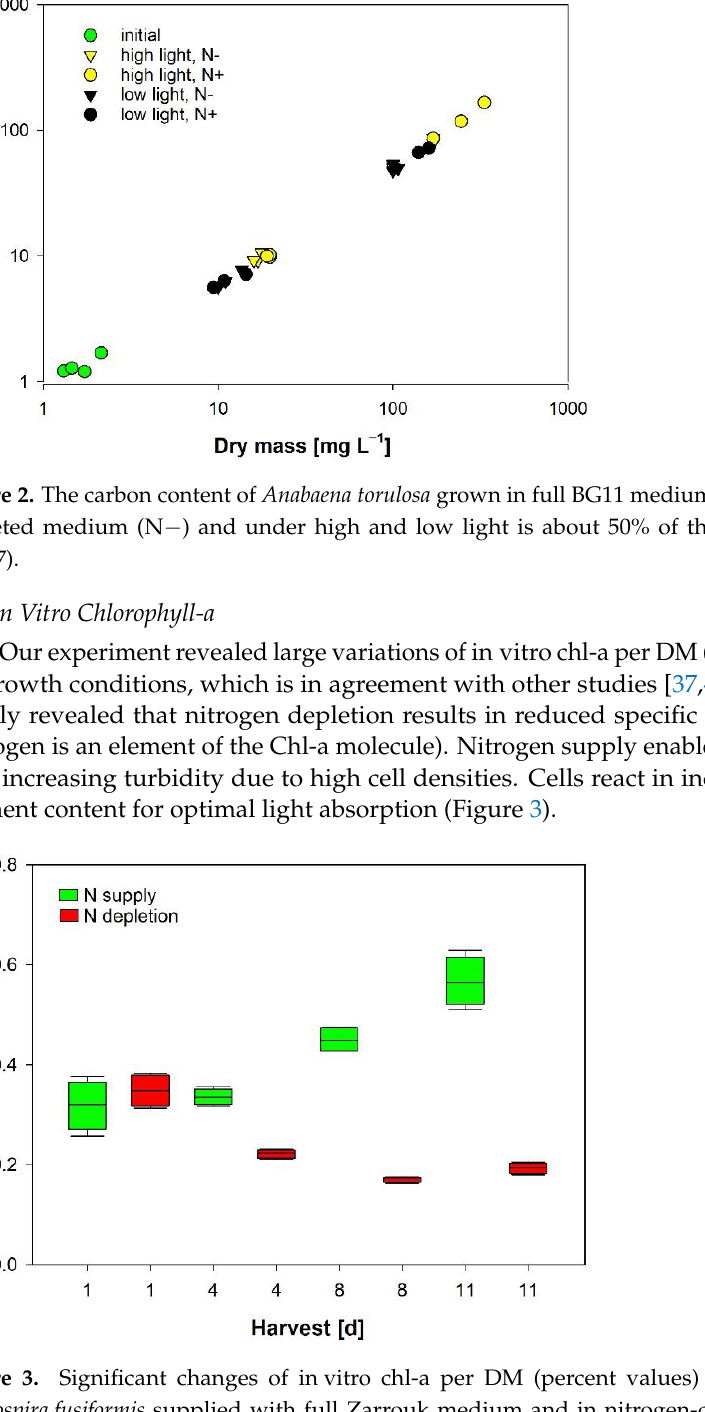
Figure 3. Significant changes of in vitro chl-a per DM (percent values) during cultivation of Limno- spira fusiformis supplied with full Zarrouk medium and in nitrogen-depleted medium (rm-Anova with time and nitrogen supply as factors). Mean and standard deviation (n = 4).